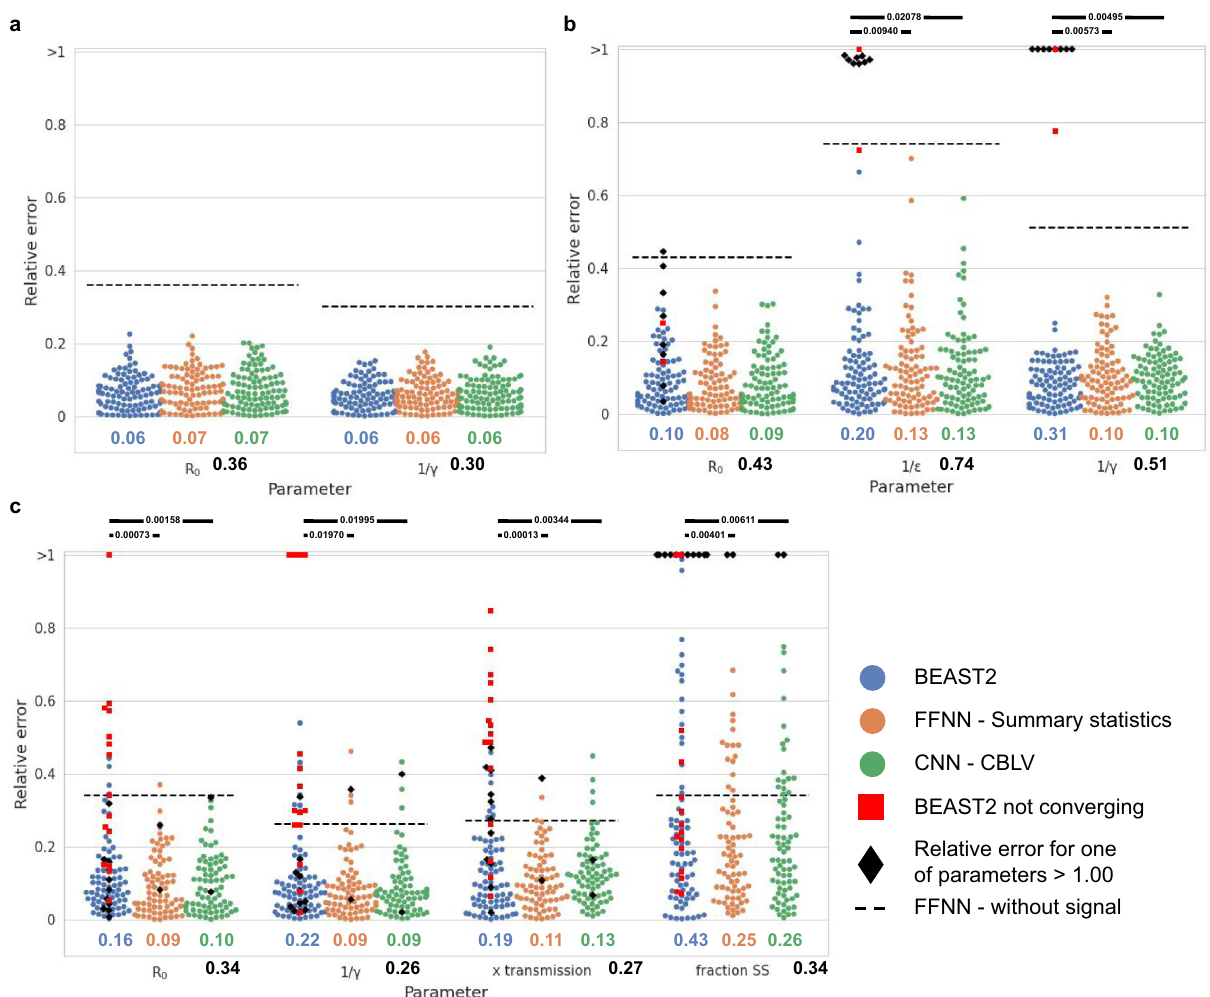
Fig. 3 Assessment of deep learning accuracy. Comparison of inference accuracy by BEAST2 (in blue), deep neural network trained on SS (in orange) and convolutional neural network trained on the CBLV representation (in green) on 100 test trees. The size of training and testing trees was uniformly sampled between 200 and 500 tips. We show the relative error for each test tree. The error is measured as the normalized distance between the median a posteriori estimate by BEAST2 or point estimates by neural networks and the target value for each parameter. We highlight simulations for which BEAST2 did not converge and whose values were thus set to median of the parameter subspace used for simulations, by depicting them as red squares. We further highlight the analyses with a high relative error (>1.00) for one of the estimates, as black diamonds. We compare the relative errors for a BD-simulated, b BDEI-simulated and c BDSS-simulated trees. Average relative error is displayed for each parameter and method in corresponding colour below each fi gure. The average error of a FFNN trained on summary statistics but with randomly permuted target is displayed as black dashed line and its value is shown in bold black below the x-axis. The accuracy of each method is compared by two-sided paired z-test; P < 0.05 is shown as thick full line; non- signi fi cant is not